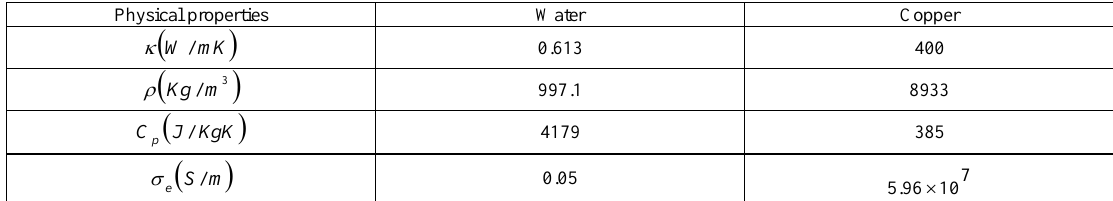
Table 1. Thermophysical characteristics of used